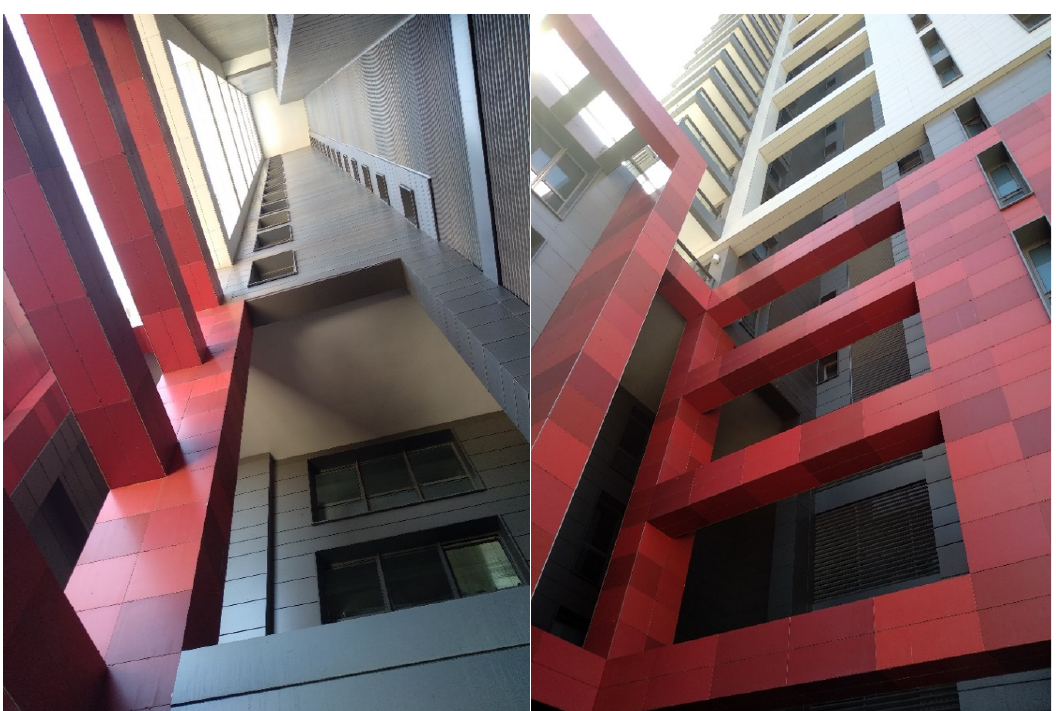
Figure 3. The ‘dress’ zoom-in. Source: Authors (2019). floor up, covering the six residential towers (Figure